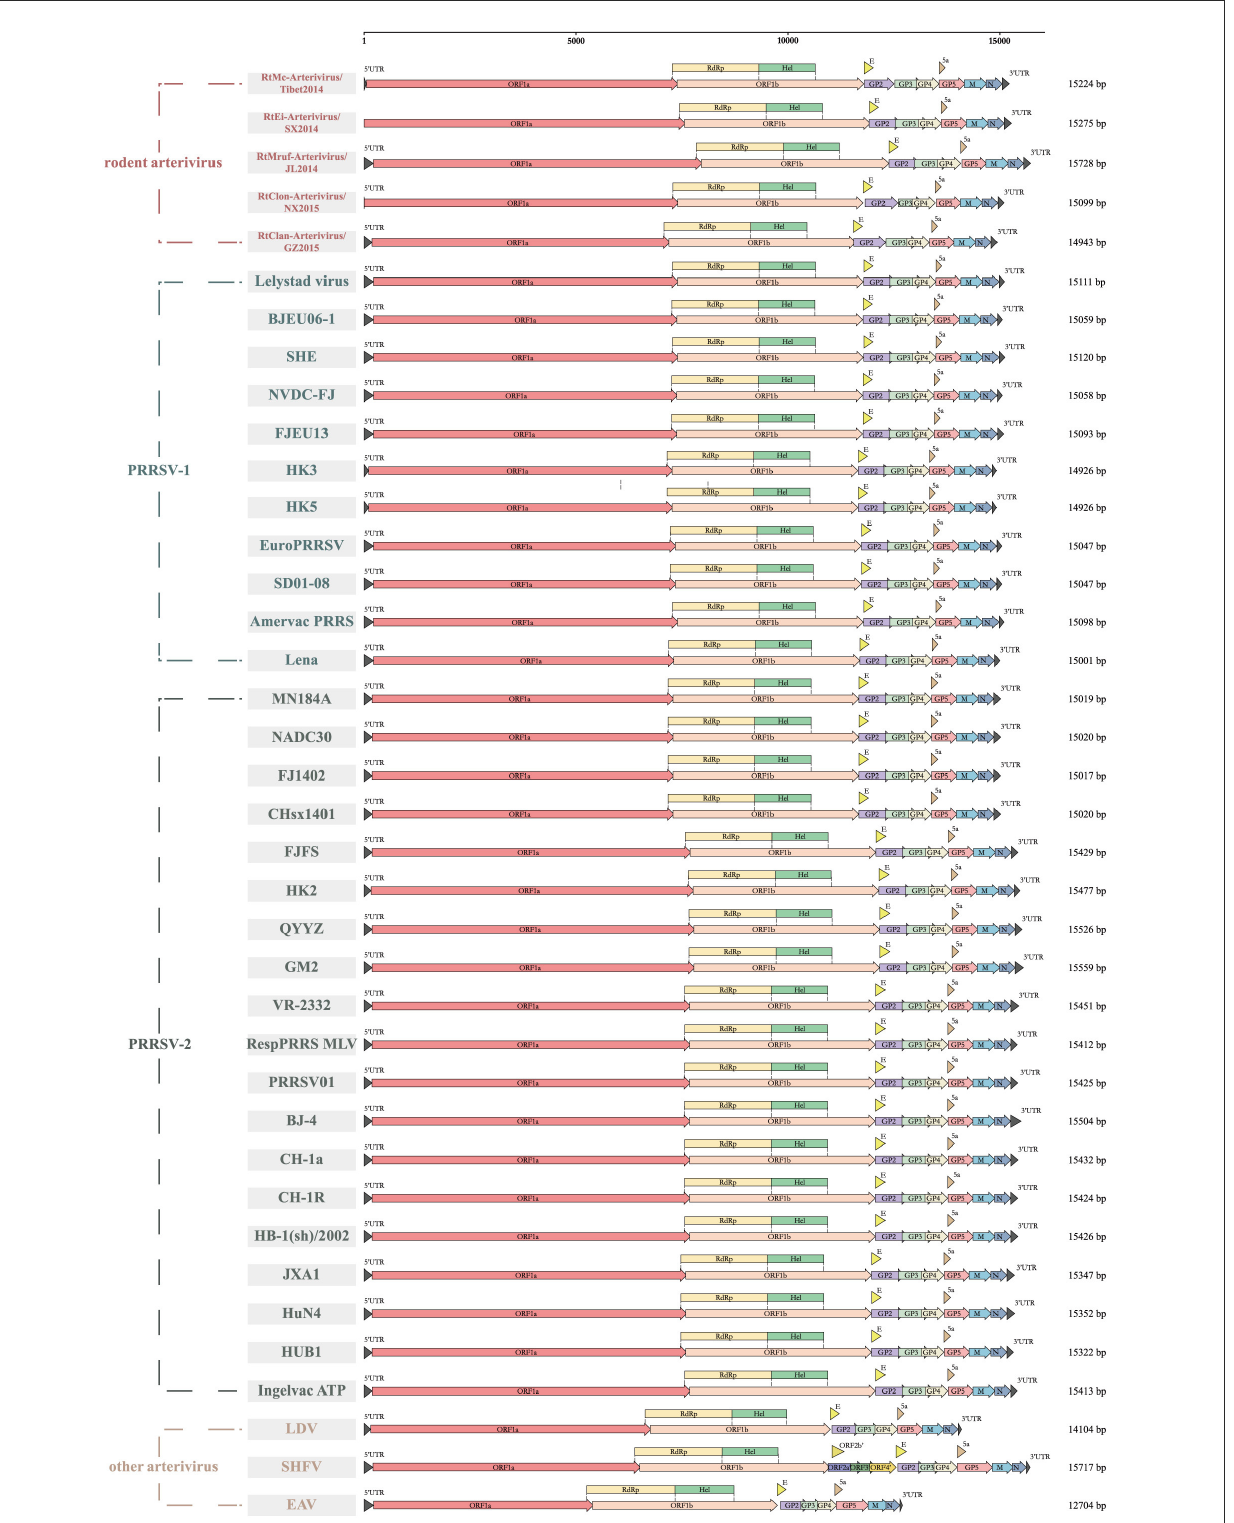
FIGURE1 Genome organization of different arteriviruses. Every ORF is marked to show the genomic differences among them. ORF1a, ORF1b, GP2, envelope (E), GP3, GP4, 5a, GP5, membrane (M), nucleocapsid (N) are represented by boxes of different colors.